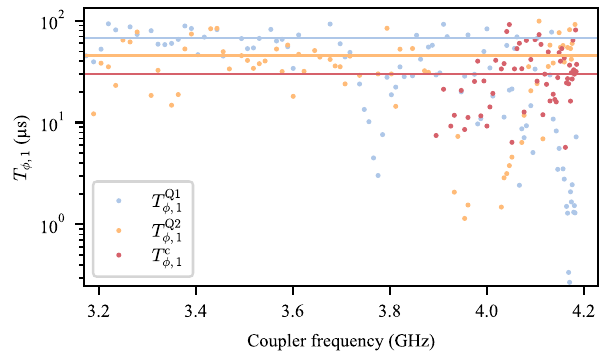
FIG. 13. The exponential part of the dephasing times as a func- tion of the coupler frequency for the hybridized modes. For the coupler frequencies relevant for the CZ gate, the exponential part of dephasing mostly stays constant, except for a sharp drop at 3.8 GHz for qubit 1. We observe the feature to move to different fre- quencies over time, indicating that it originates from a spectrally active TLS. The solid lines show the median of the measured exponential dephasing rates, evaluated at the frequencies relevant . for the CZ gate and used for calculating T k φ ,1,eff